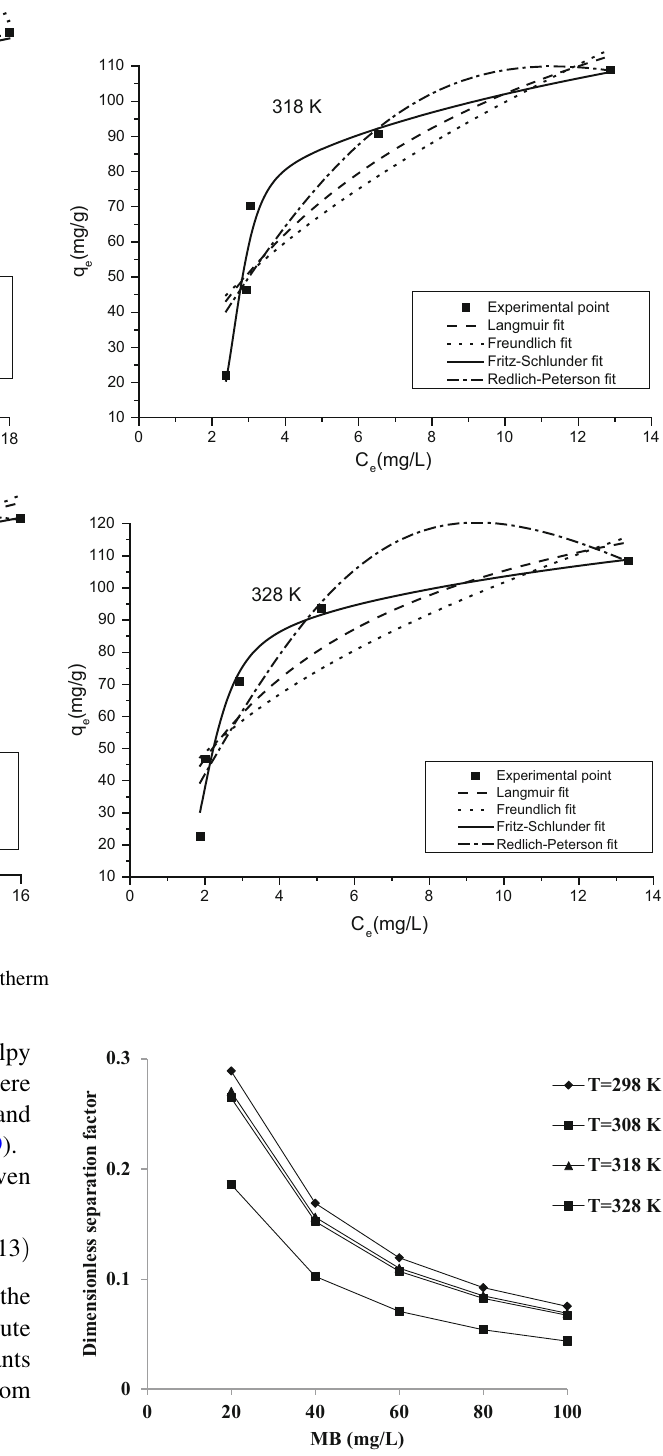
Fig. 10 Dimensionless separation factor, R L , versus MB